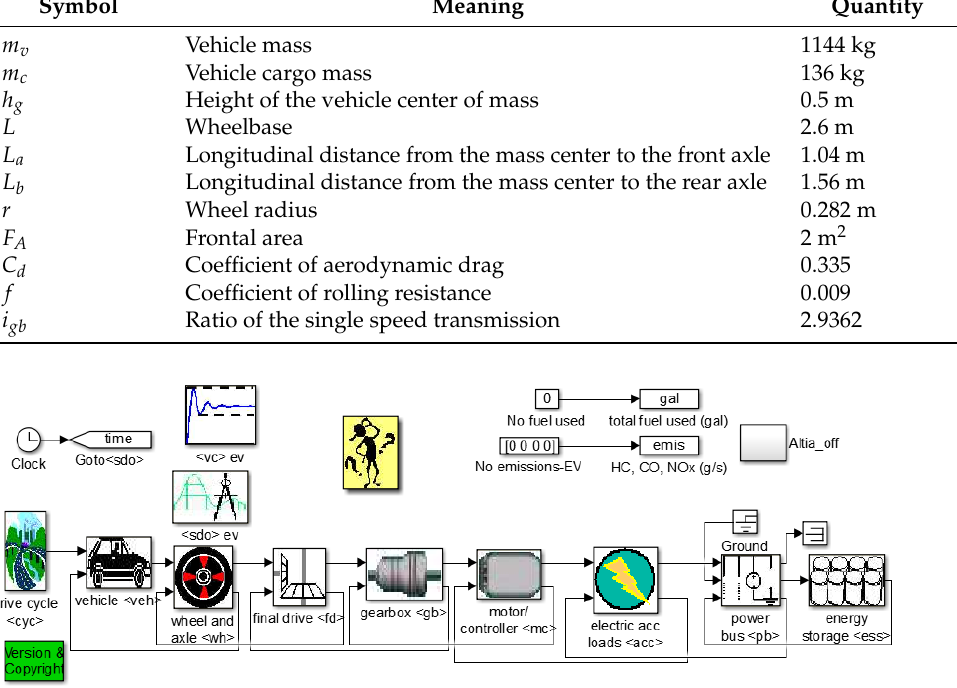
Figure 2. Pure EV model in ADVISOR.